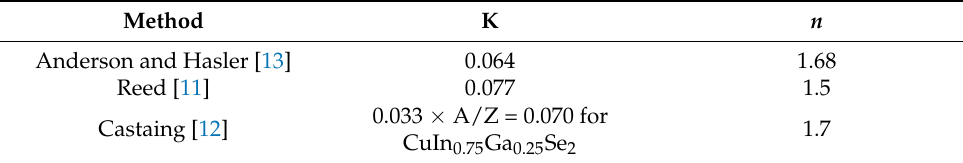
Table 2. Different K and n factors for the calculation of the X-ray range R x .